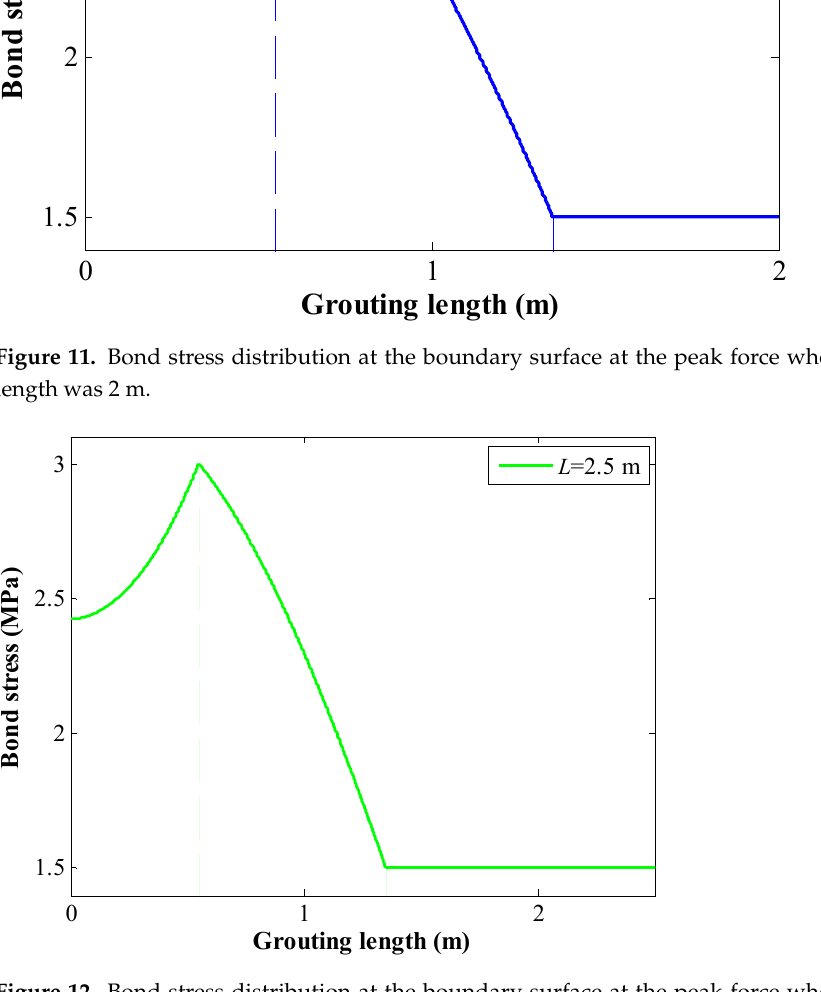
Figure 12. Bond stress distribution at the boundary surface at the peak force when the grouting length was 2.5 m.